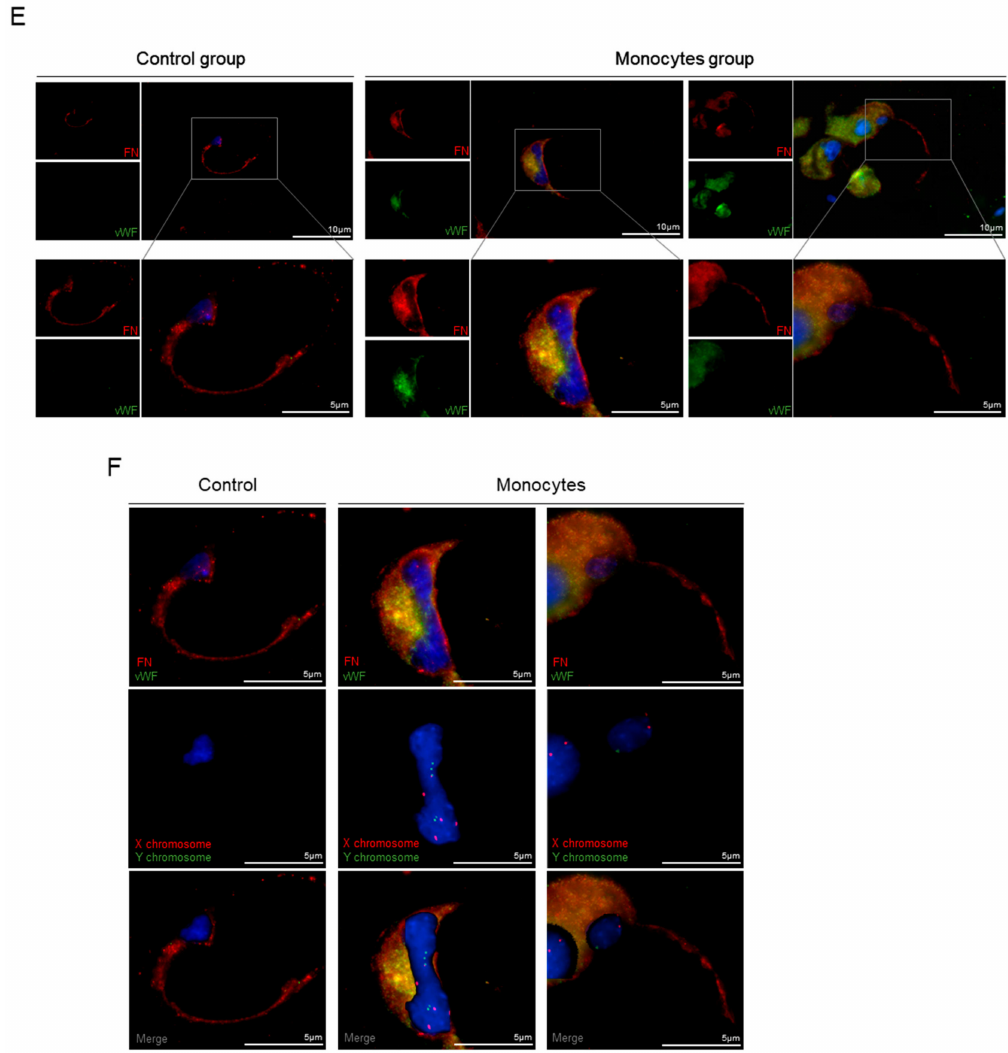
Figure 3. Monocytes exposed to VEGF are able to form blood vessels in vivo. ( A ) Plug images 21 days after monocyte inoculation in matrigel with VEGF. Control plugs were inoculated in the absence of monocytes. ( B ) Hematoxylin and eosin staining from the para ffi n embedded plugs (bars 150 µ m and 50 µ m). ( C ) Relative density of vessel-like structures per area ( µ m) in plugs ( n = 4 per group). ( D ) Human CD31 (hCD31) by immunohistochemistry. Optical microscopy, nuclei are blue (hematoxylin) (bars 100 µ m). ( E ) Human vWF (hvWF; green) and fibronectin (FN, red) staining by immunofluorescence in plug blood vessels (bars 10 µ m and 5 µ m). ( F ) The same sections ( E ) were submitted to FISH analysis for the human X (red) and Y (green) chromosome (bars 5 µ m). Nuclei are blue (DAPI). ** p ≤